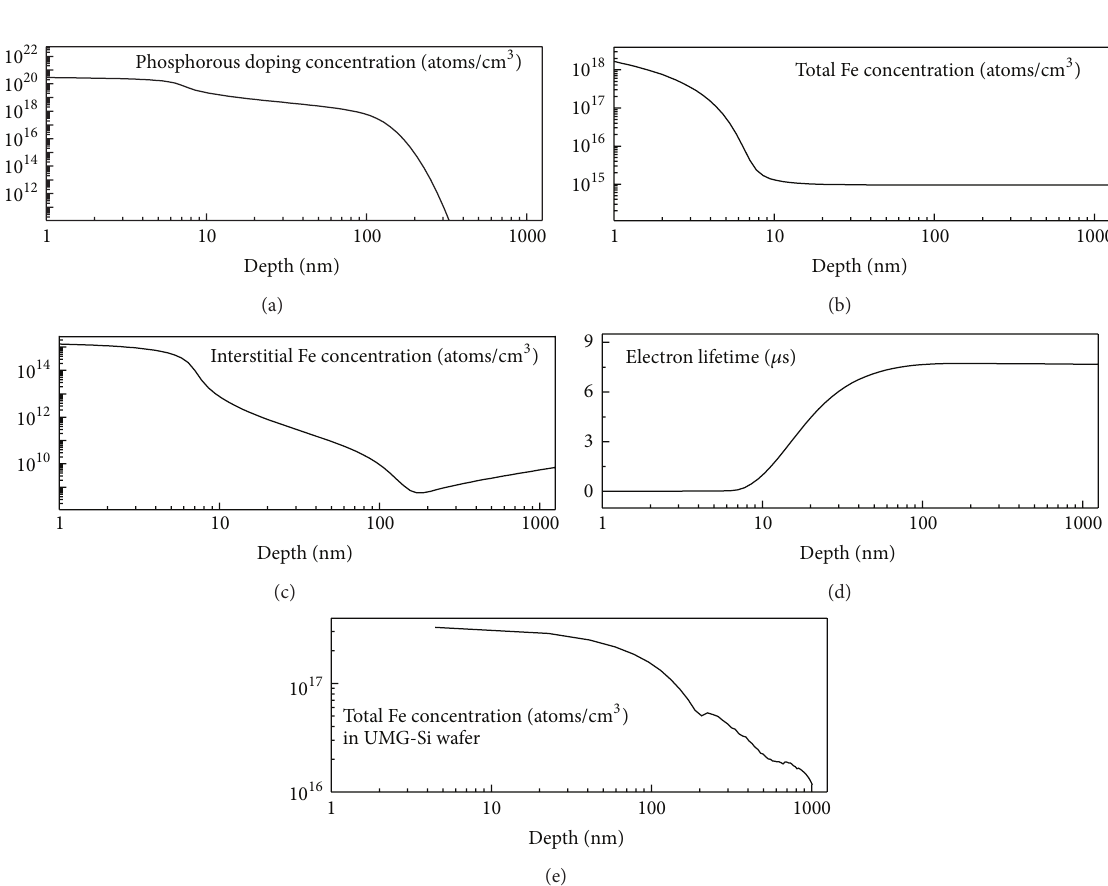
Figure 1: Calculated distributions of P dopant concentration, total Fe concentration, interstitial Fe concentration, and electron lifetime (from the upper graph) after the gettering process at 700 ∘ C for 30min. The lowest graph is the bulk Fe concentration by means of SIMS measurement of the UMG-Si gettered at 700 ∘ C for 5